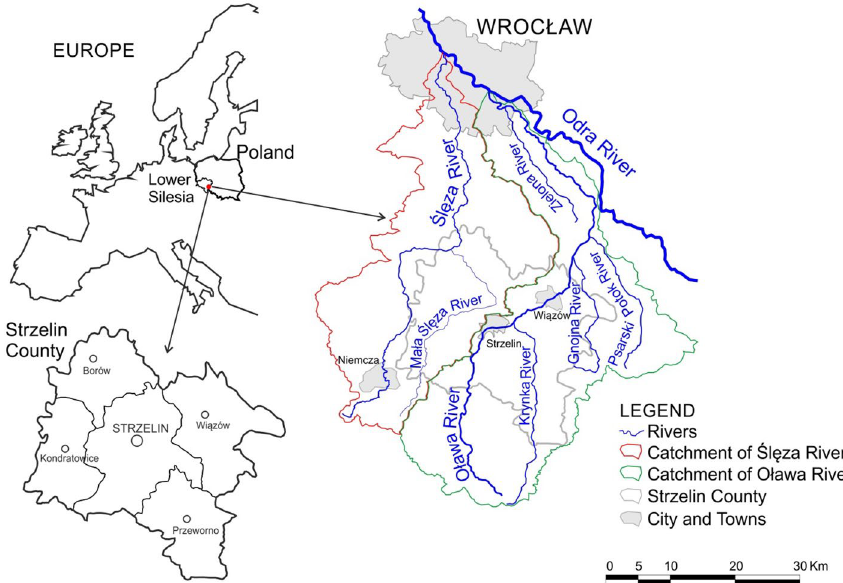
Figure 1. Catchments of the Ślęża and Oława Rivers in Europe and Poland.